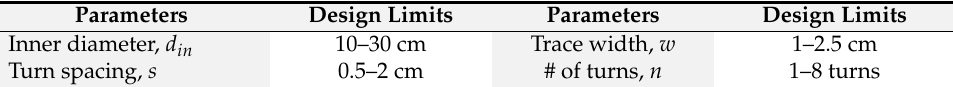
Table 1. Design spans of transmitter and receiver